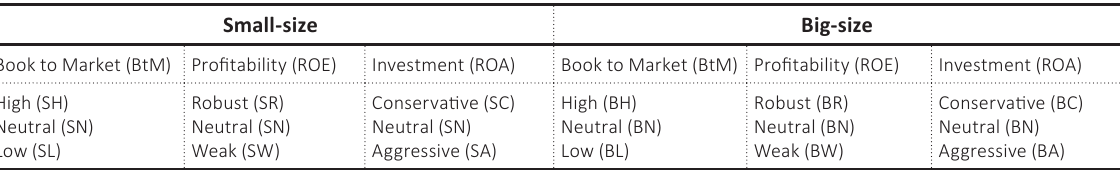
Table 2. Small-size and big-size portfolios according to the modified approach Source: Developed by the authors based on Fama аnd French